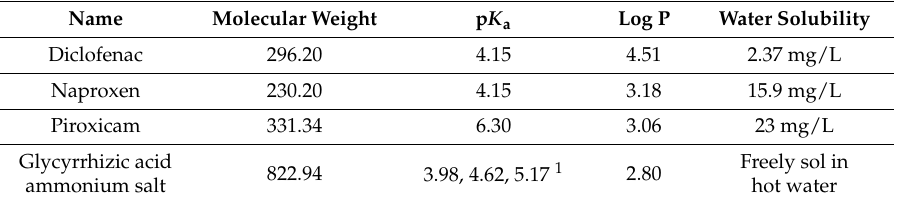
Table 1. Physicochemical properties of the model drugs tested in this work.